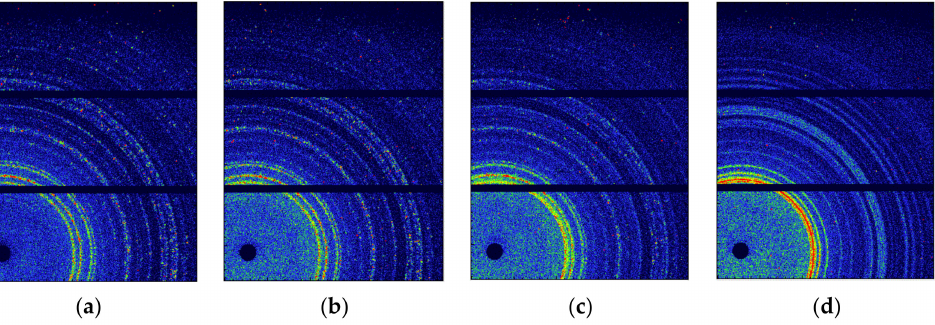
Figure 1. WAXS patterns of CL-20 heating at different temperatures: ( a ) 30 ◦ C; ( b ) 160 ◦ C; ( c ) 170 ◦ C; ( d ) 200 ◦ C.